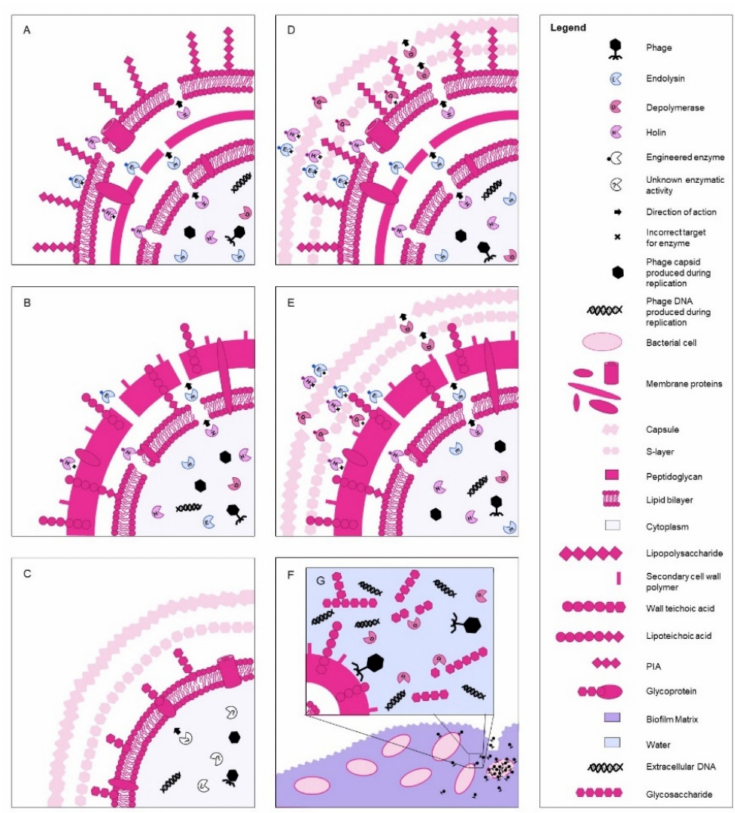
Figure 1. Phage/enzymatic action on a variety of cell types (see legend for names of components). Arrows indicate the direction of action of the enzymes during a natural phage infection